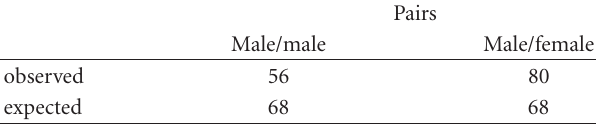
Table 2: X 2 0 . 05,1 , 2 × 2 contingency table to illustrate the statistical method adopted. This example is for pooled data to test the null hypothesis that there is no di ff erence between columns.